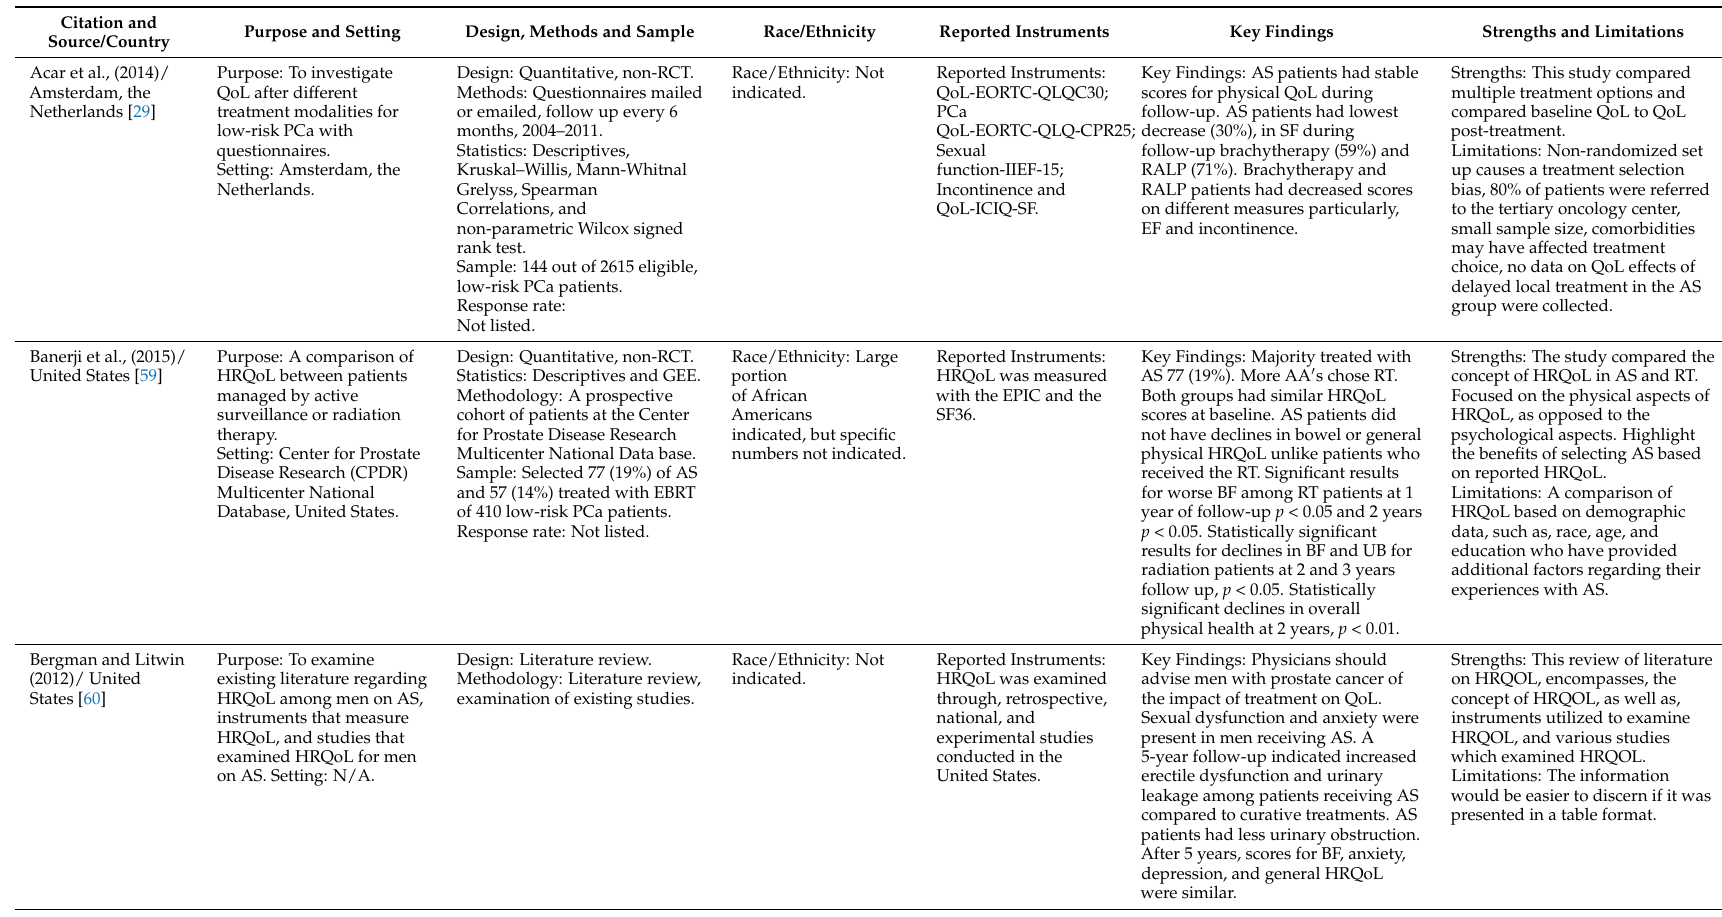
Table 1. Sexual, bladder and bowel function and anxiety and depression among men utilizing active